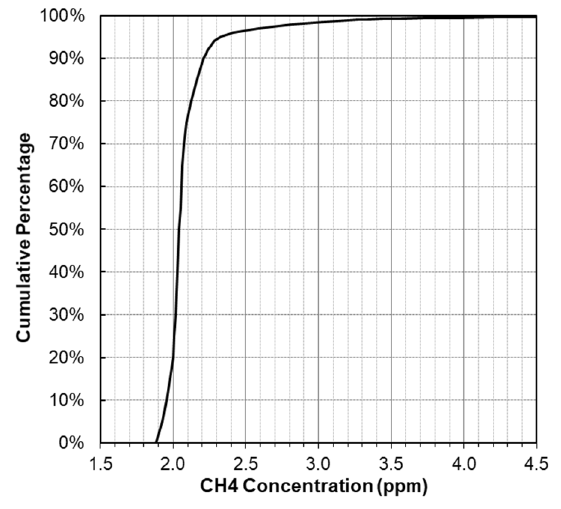
Figure 3. Cumulative probability plot of 1-s CH 4 measurements in data subset 1.